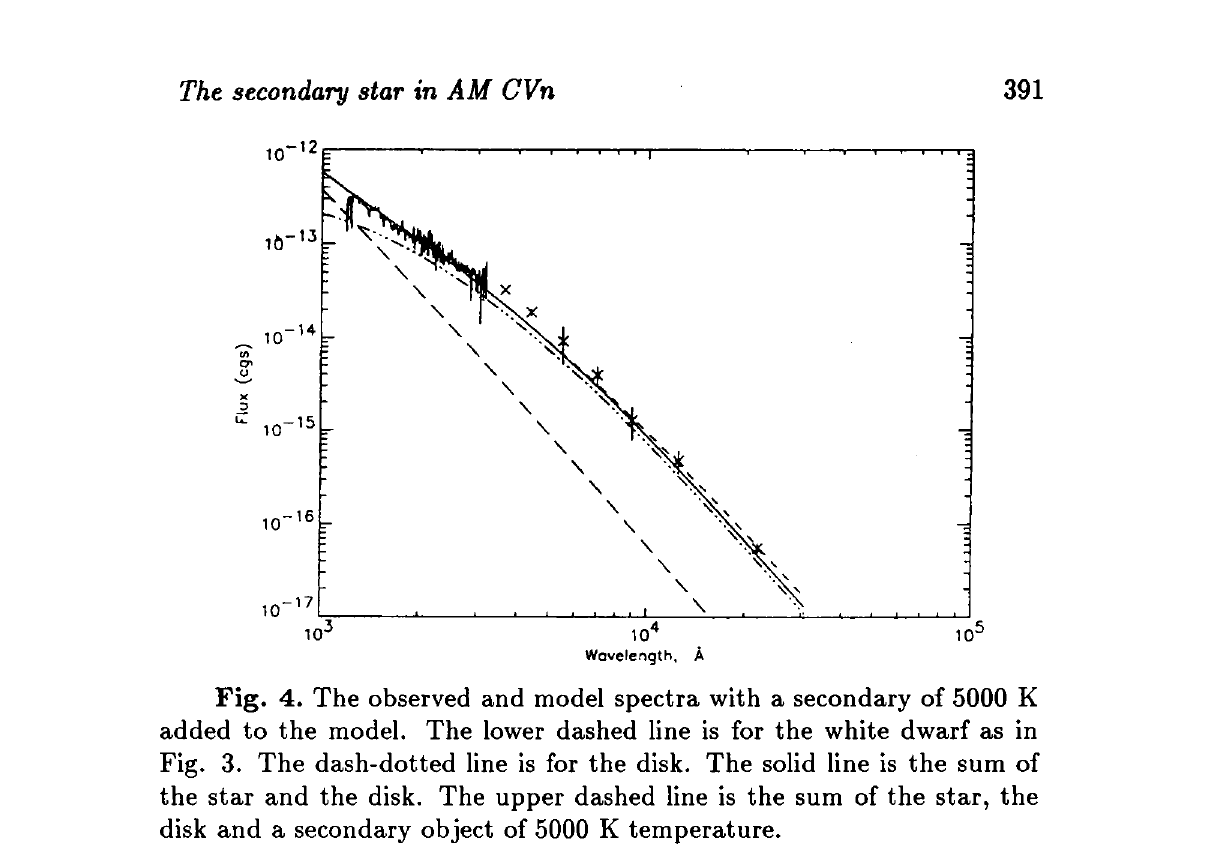
Fig. 4. The observed and model spectra with a secondary of 5000 K added to the model. The lower dashed line is for the white dwarf as in Fig. 3. The dash-dotted line is for the disk. The solid line is the sum of the star and the disk. The upper dashed line is the sum of the star, the disk and a secondary object of 5000 K temperature.